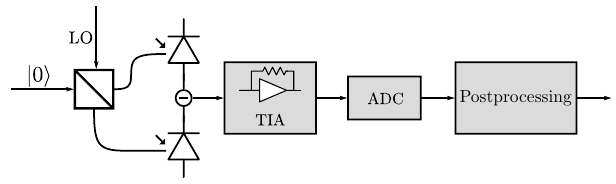
FIG. 1. The block diagram for a quantum random number generator based on the quadrature measurement of the vacuum state | 0 (cid:2)